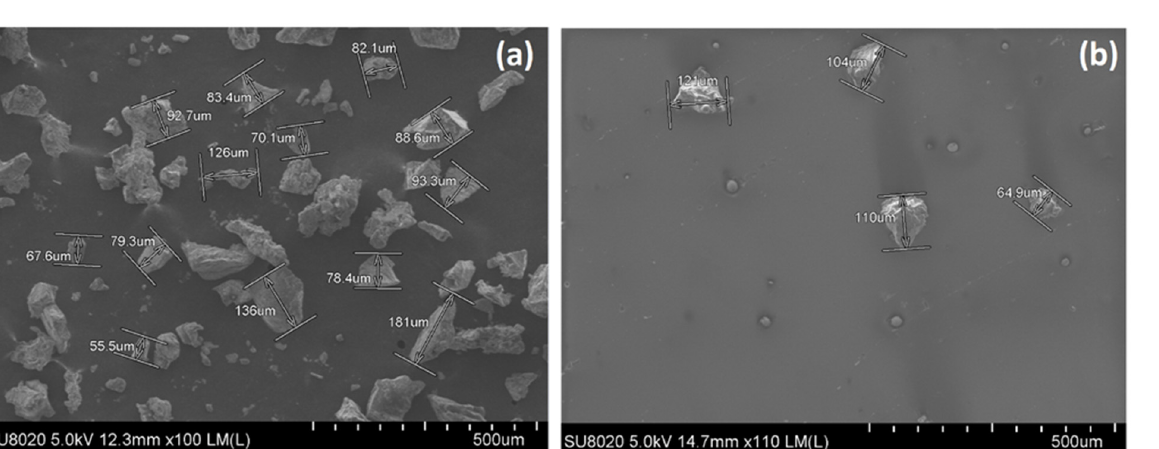
Figure 1. SEM micrograph of ( a ) GTR and ( b ) DevGTR.